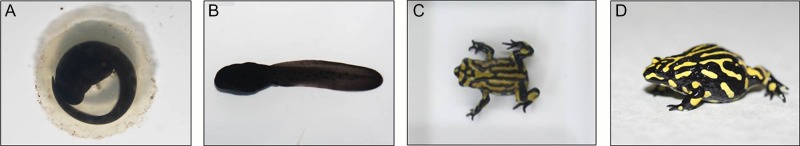
The life-stages of P. corroboree. Shown in the (A) embryonic life-stage (development within the jelly capsule), (B) larval life-stage (tadpole post-hatching), (C) juvenile life-stage (newly metamorphosed frog) and (D) adult life-stage. Photographs A, B, and D are courtesy of A.J. Silla, photograph C is courtesy of E.P. McInerney.